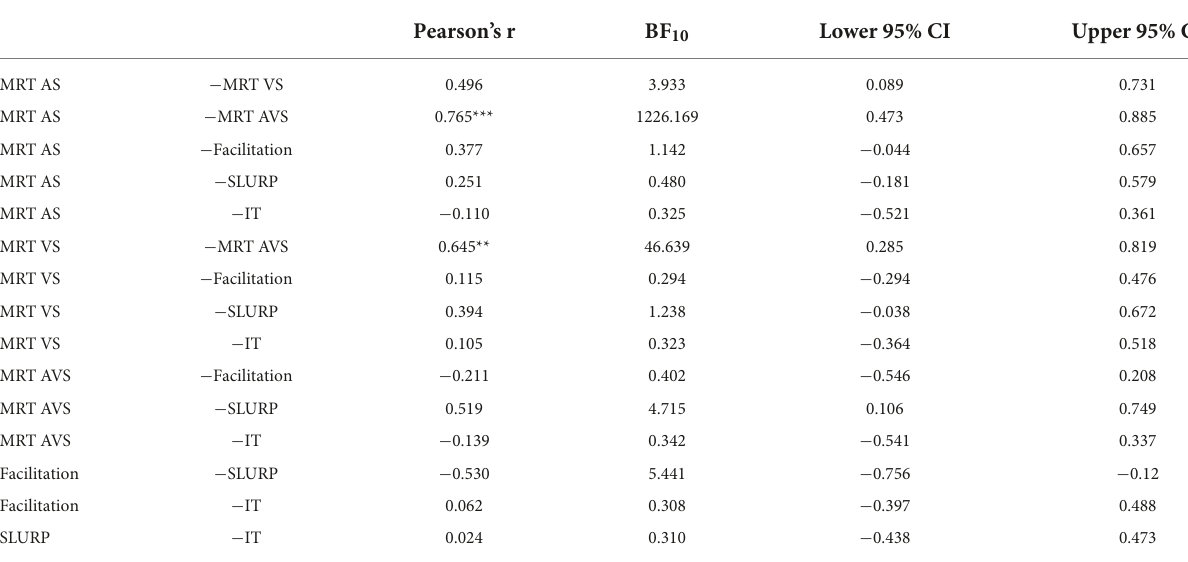
TABLE 4 Bayesian Pearson Correlations, 5 − 6